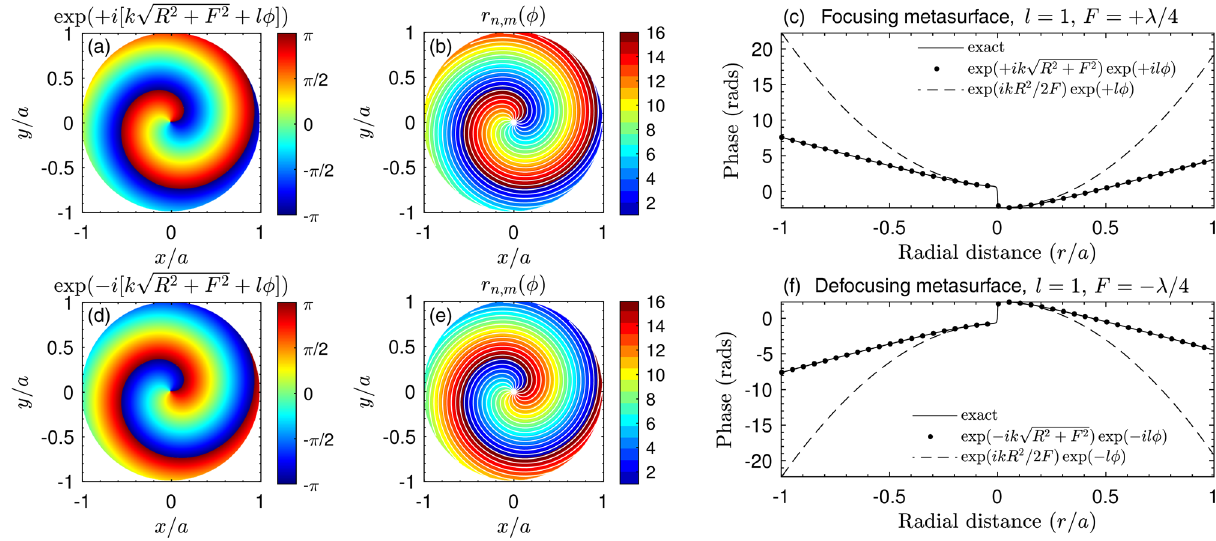
Figure 2. ( a ) Scheme of the proposed spiral-shaped sound diffusing metasurface. ( b ) Geometry of the panel for the focusing configuration. ( c ) Spiral metasurface for the focusing configuration and its geometry. ( d ) Spiral metasurface designed for the defocusing configuration using a virtual image of a vortex and its